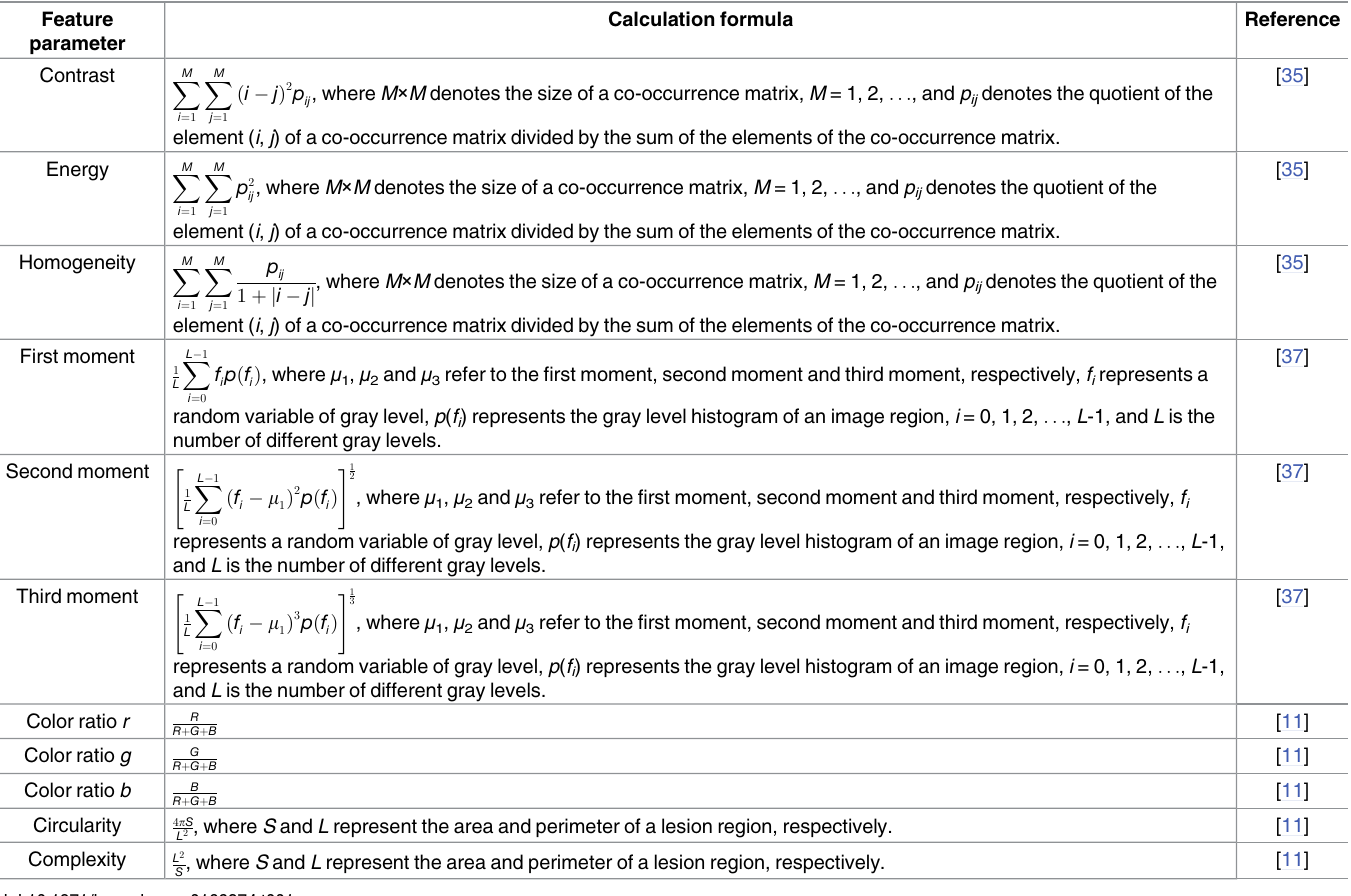
Table 1. Extracted image features (excluding Hu invariant moments) and calculation formulas. Feature